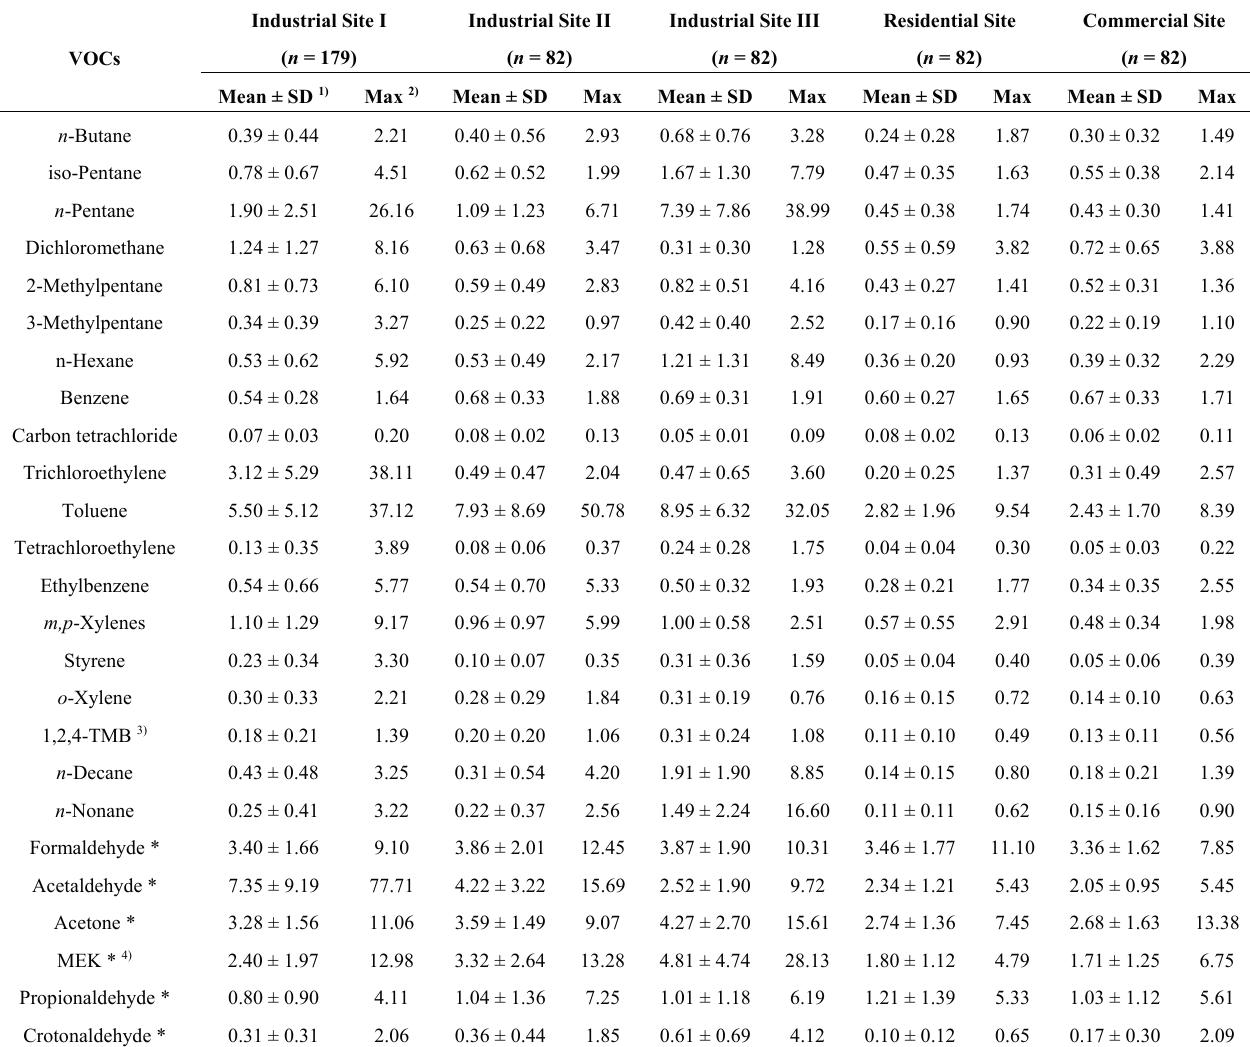
Table 3. Concentrations (in ppb) of selected VOCs in Gumi city during